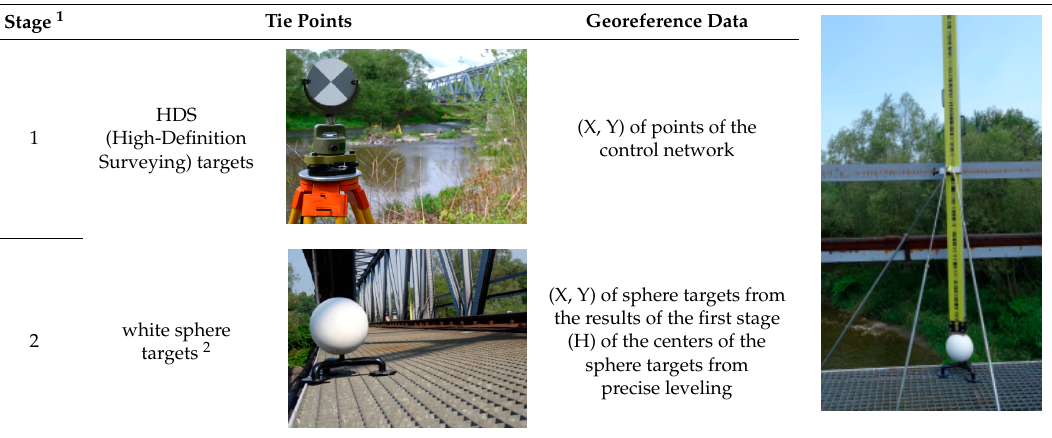
Table 6. Diagram of the point cloud registration steps.